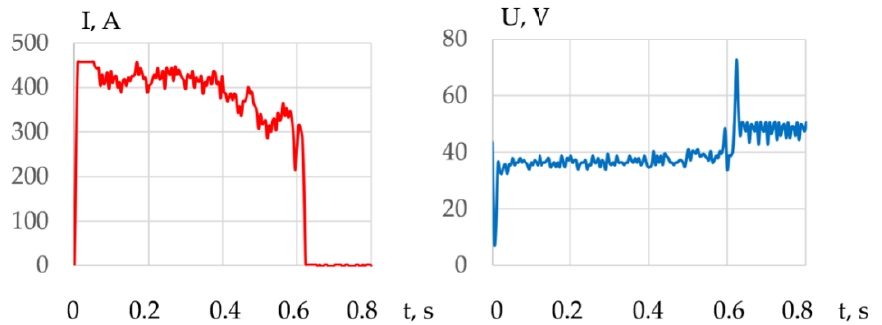
Figure 18. Typical change in the current and voltage during a working cycle when cutting 10 KhSND steel with PPR-APL1-1 wire for cut no. 6.